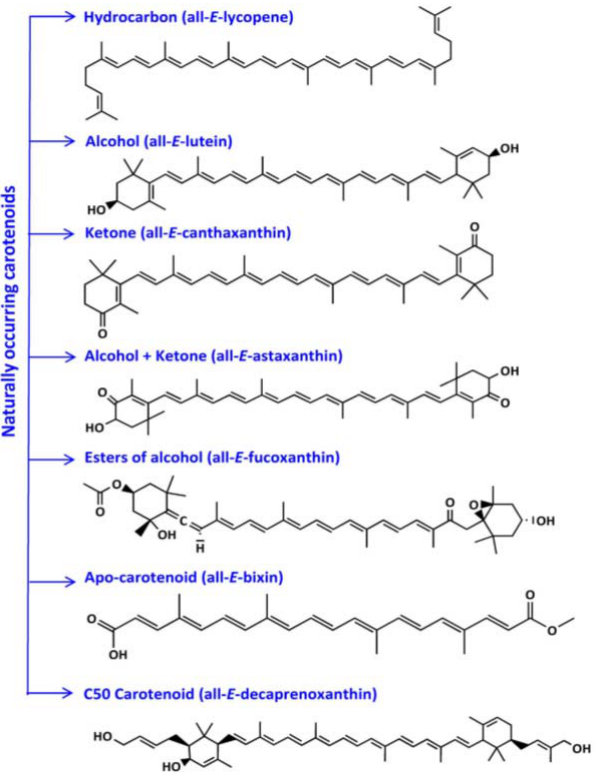
Figure 3. Carotenoids widespread in nature